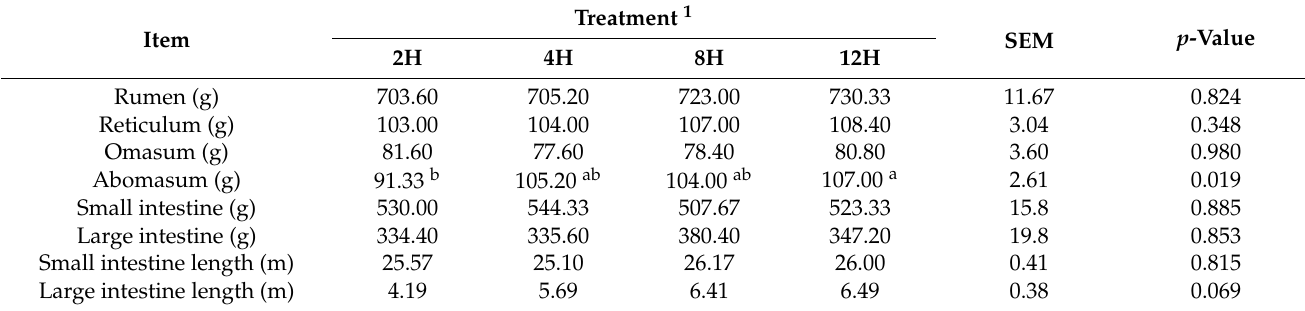
Table 1. Digestive organs of lambs following different grazing treatments.